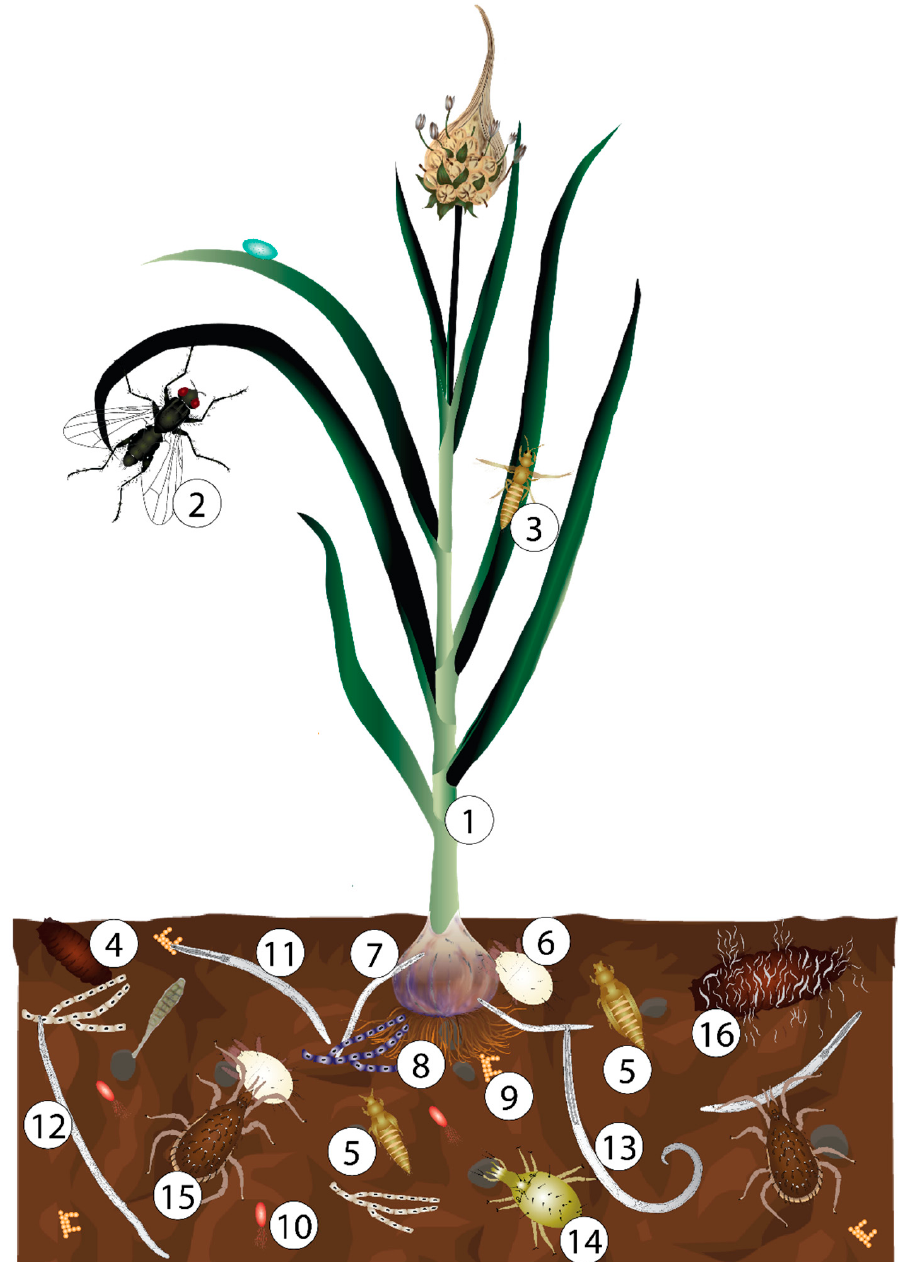
Figure 1. Schematic representation of some organisms (in part or in their entire life cycle) composing the soil food web associated with bulb crops. In such soils, complex interactions occur between bacteriophages, decomposers, fungivores, microbial grazers, parasites, phytophages, predators, saprophytes, among others. Key to food web diagram: ( 1 ) bulbous plant, ( 2 ) onion fly (e.g., Delia antiqua (Meigen)), ( 3 ) Thysanoptera (e.g., Thrips tabaci Lindeman), ( 4 ) fly pupa, ( 5 ) pupa and pre- pupa of Thysanoptera, ( 6 ) bulb mite (e.g., Rhizoglyphus robini Clapar è de), ( 7 ) plant parasitic nema- todes, ( 8 ) fungi, ( 9 ) and ( 10 ) bacteria, ( 11 ) bacteriophagous nematodes, ( 12 ) fungivorous nematodes, ( 13 ) predatory nematodes, ( 14 ) predatory Prostigmata mites, ( 15 ) predatory Mesostigmata